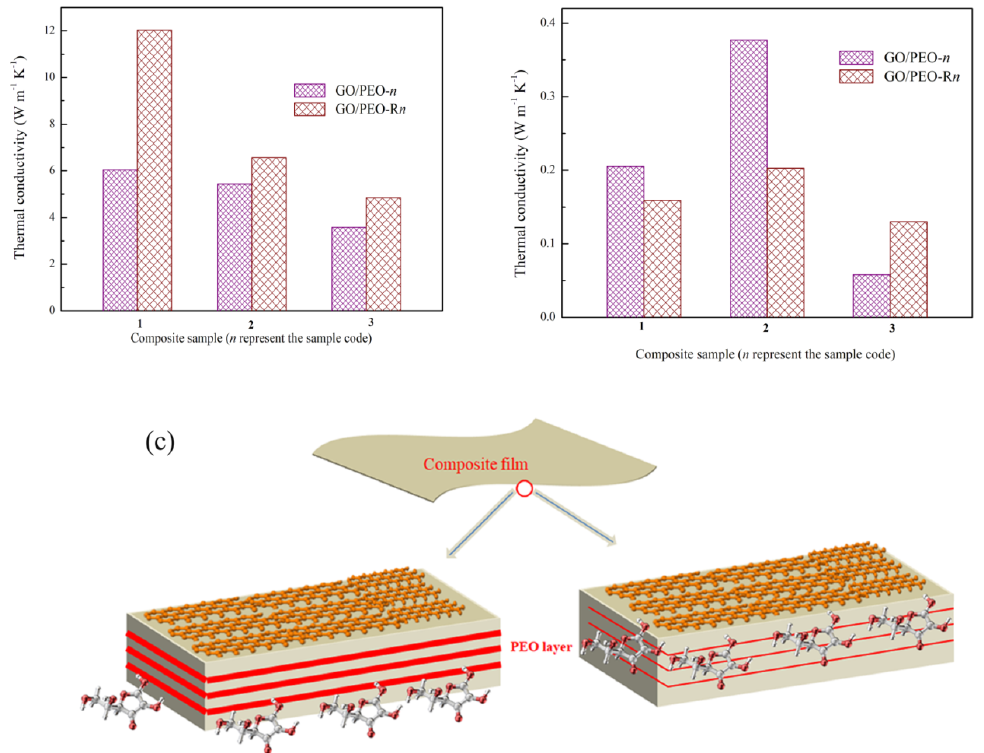
Figure 7. In-plane ( a ) and out-of-plane ( b ) thermal conductivity of GO/PEO composite films with and without reduction; ( c ) reduction diagrams of the GO/PEO composite films.